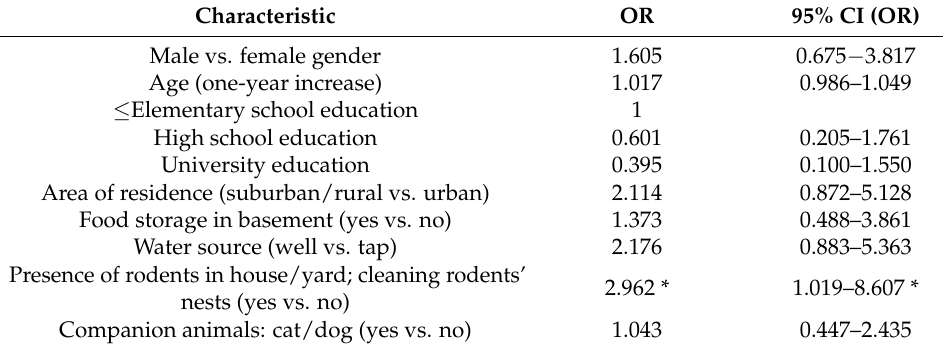
Table 3. Logistic regression risk for LCMV IgG